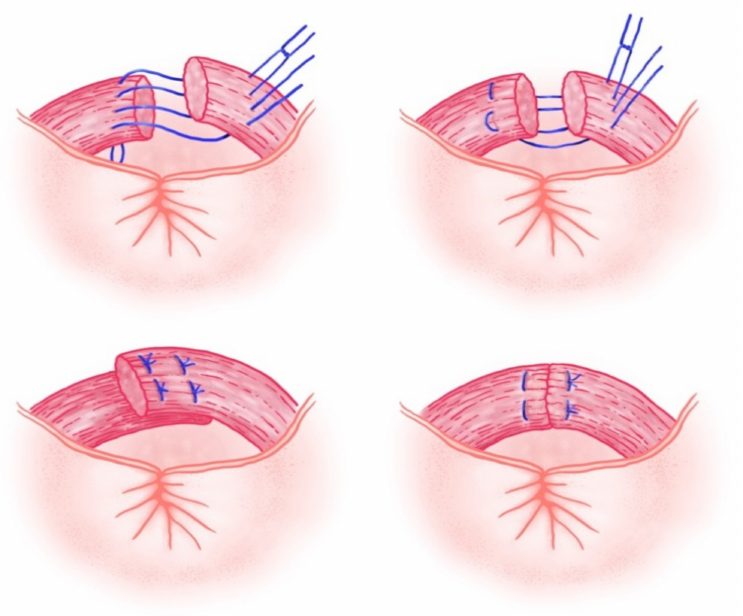
Figure 4. Methods for surgical repair of anal sphincter tears: Overlap technique (images on the left) and end-to-end technique (images on the